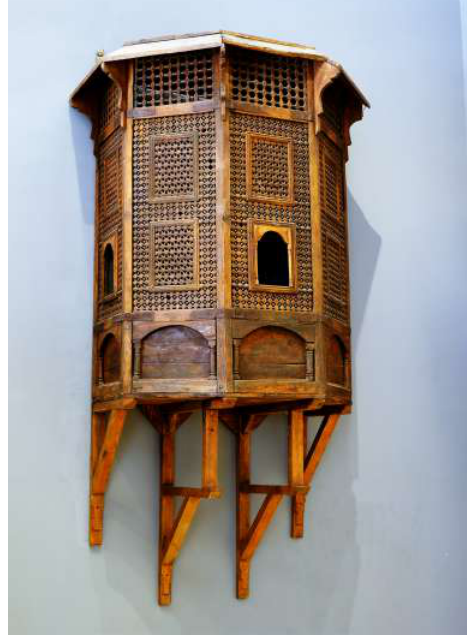
The Burj Qatar mashrabiya skin (Source: Peter Chomowicz, 2013).